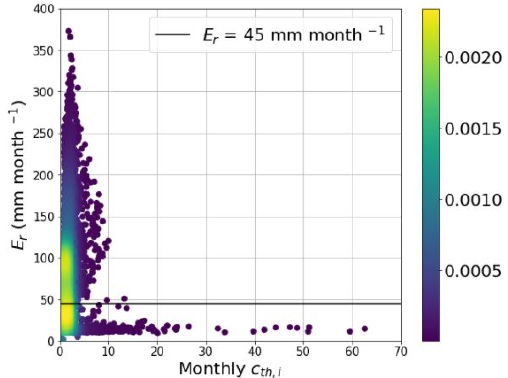
Figure 7. The 2D scatter density plot between the 6300 mean monthly c th ,i values versus the respective mean monthly E r values derived by the raw data of the 525 stations ( c th ,i = 0 or non-defined due to E r and/or E p = 0 not being included in the